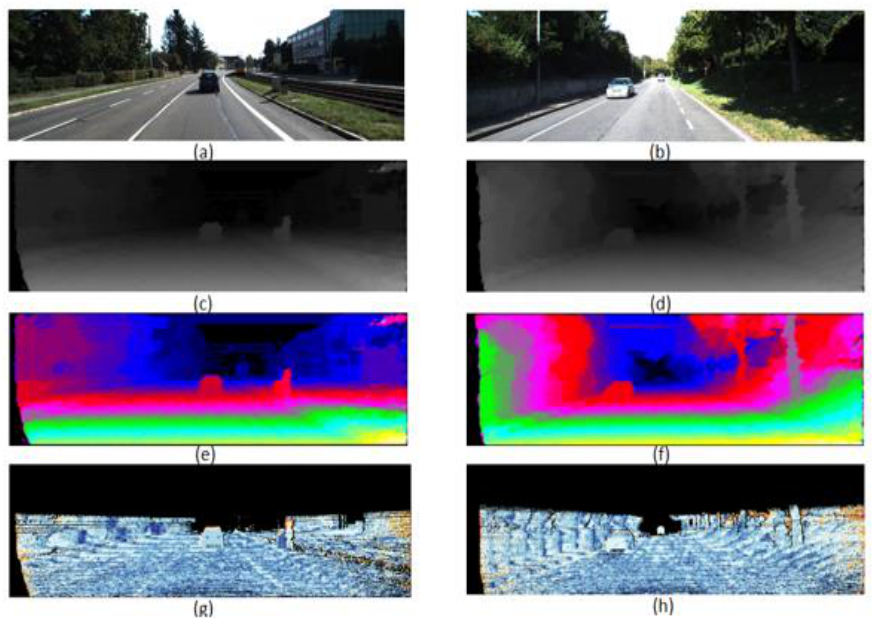
Figure 14. ( a ) No.110; ( b )No.128; ( c ) Grayscale disparity of ( a ); ( d ) Grayscale disparity of ( b ); ( e ) Pseudo-color disparity of ( a ); ( f ) Pseudo-color disparity of ( b ); ( g ) Error of ( a ) (noc:2.77%, occ:4.48%); ( h ) Error of ( b ) (noc:3.80%, occ:6.06%).